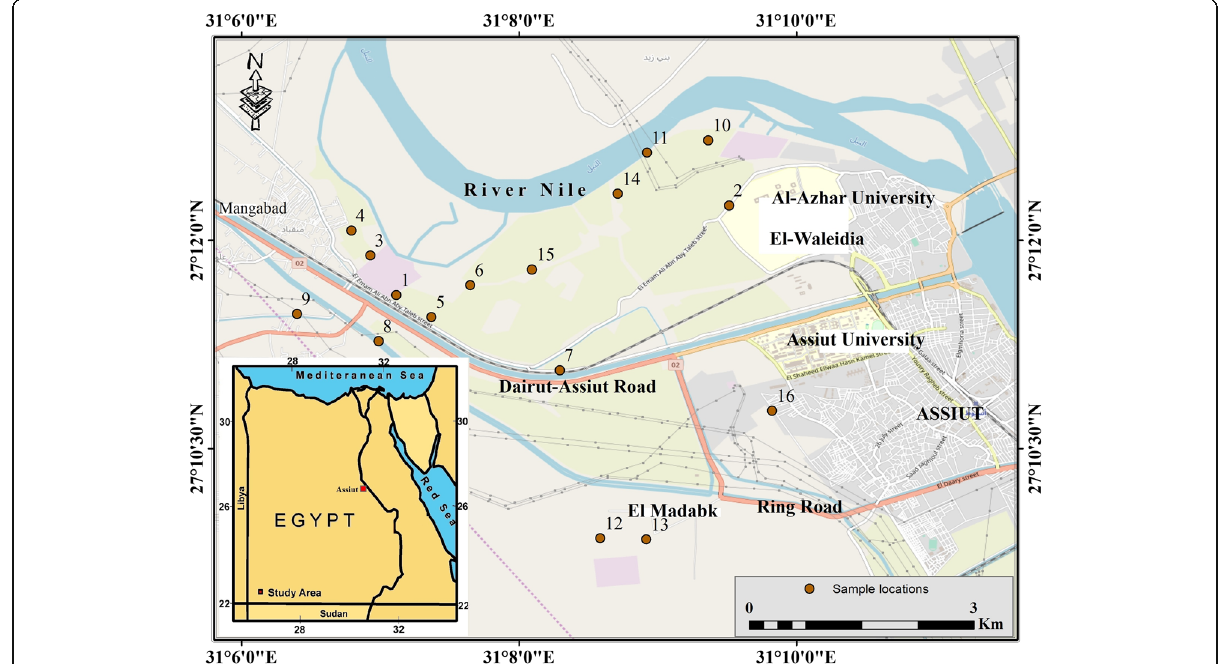
Fig. 1 Location map of the studied soil